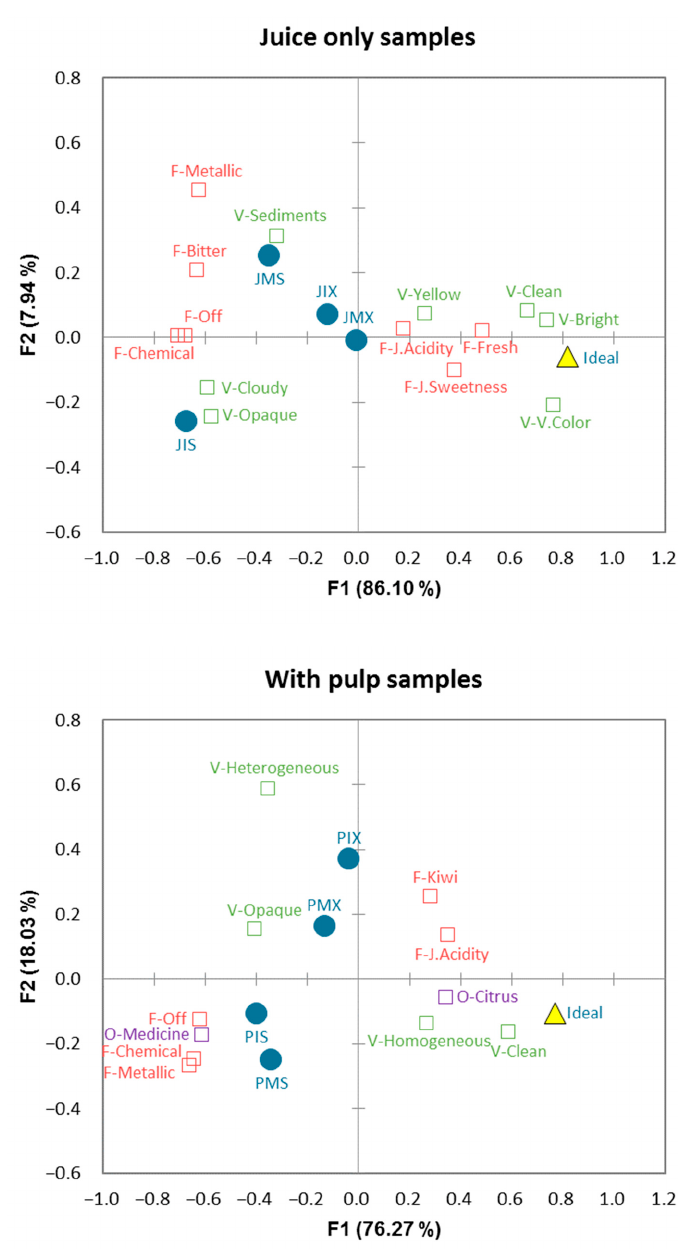
Figure 2. Representation of the lulo beverage samples (JMS, JIS, JMX, JIX, PMS, PIS, PMX, and PIX), attributes, and ideal product in the first two dimensions of the multiple correspondence analysis (MCA) of the check-all-that-apply (CATA) counts for the two groups of samples (juice only and with pulp). P = pulp, J = juice, M = maltodextrin, I = inulin, S = stevia, and X = erythritol + xylitol +